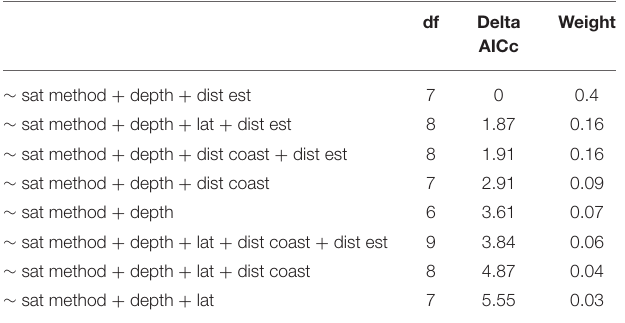
TABLE 5 | Table of the model averaged estimates, standard errors (SE) and p -values from all the most parsimonious linear mixed models. Estimate df